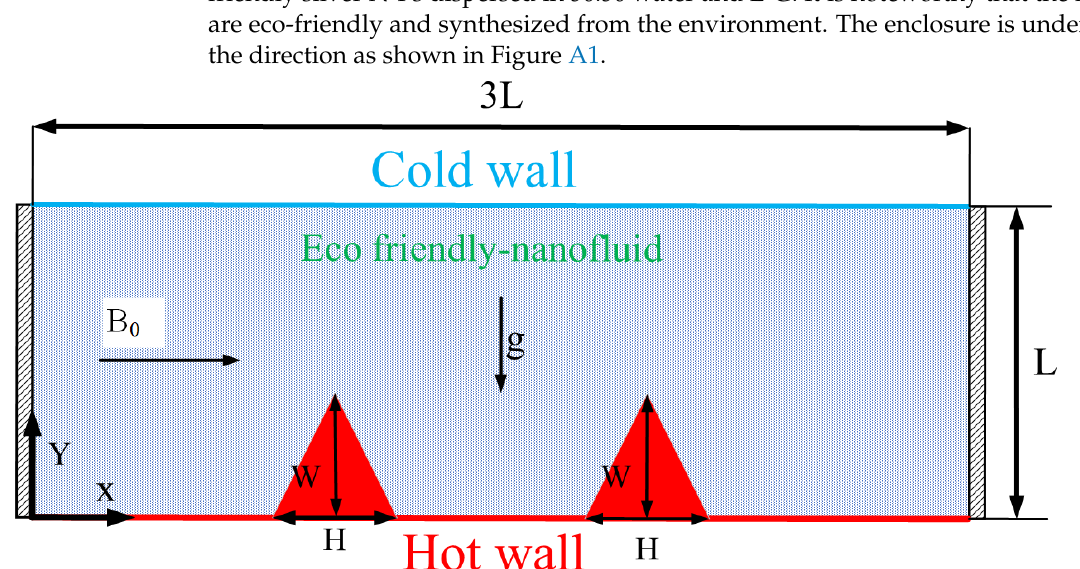
Figure 1. A schematic of the enclosure. Figure A1. A schematic of the